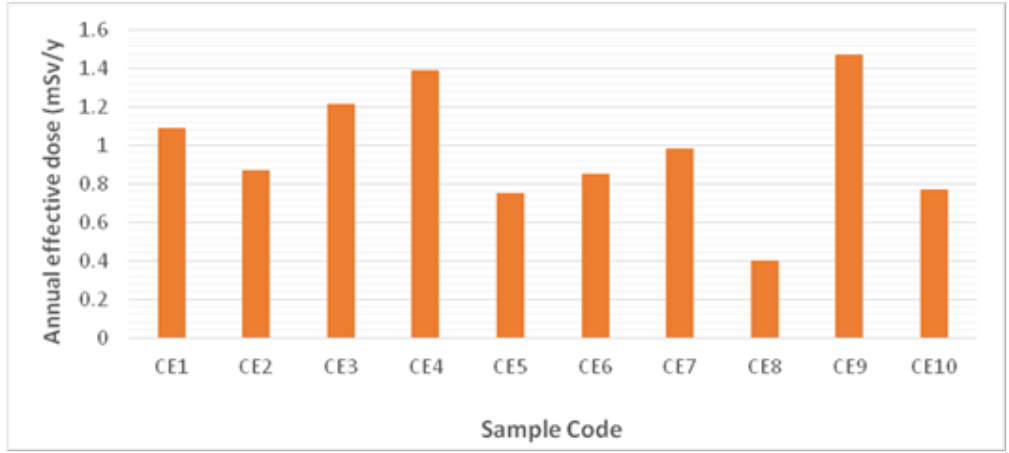
Figure 4: The annual effective dose of cement samples after painting.